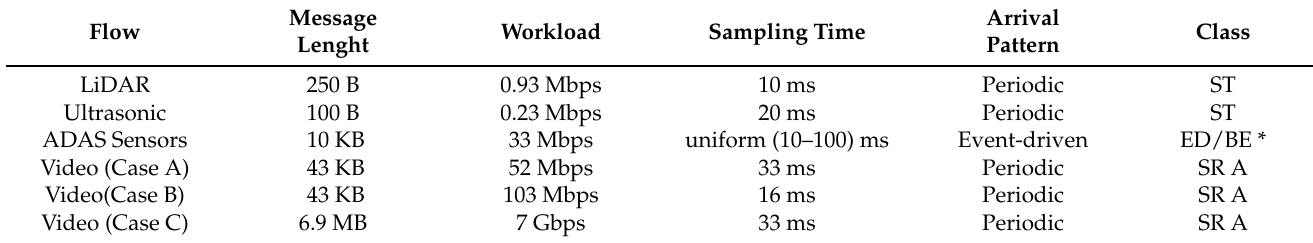
Table 1. Flow parameters and mapping on the traffic classes.